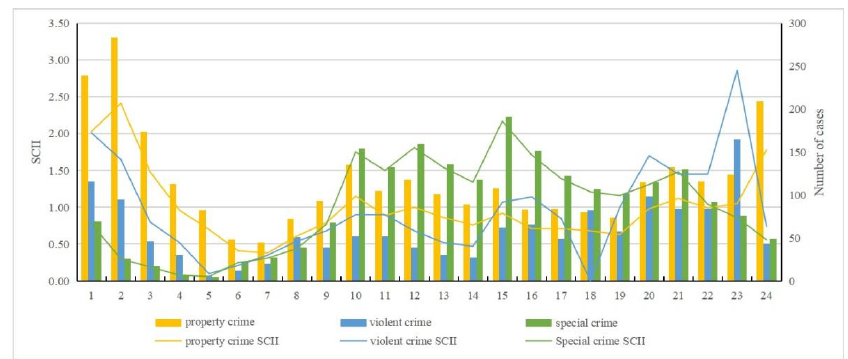
Figure 5. Standardized hourly scale crime intensity index and number of cases.